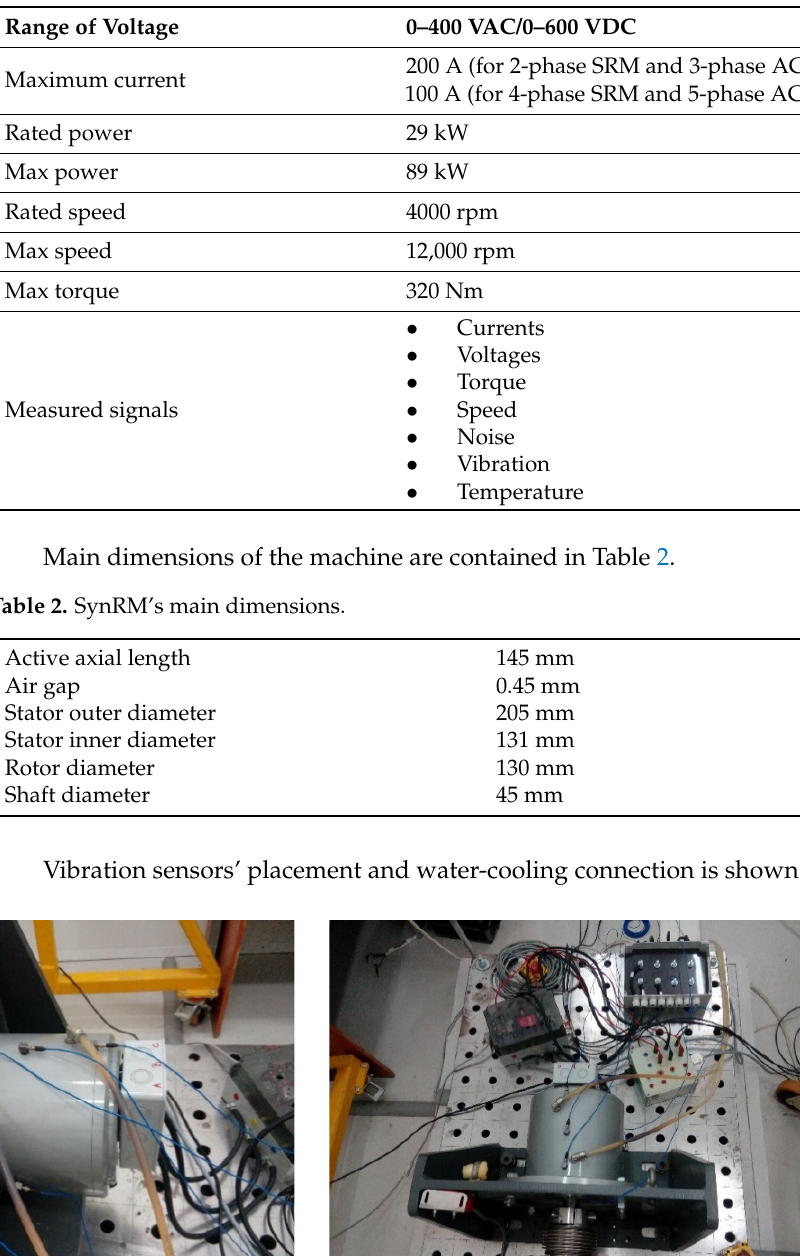
Table 3. Vibration sensor’s parameters .